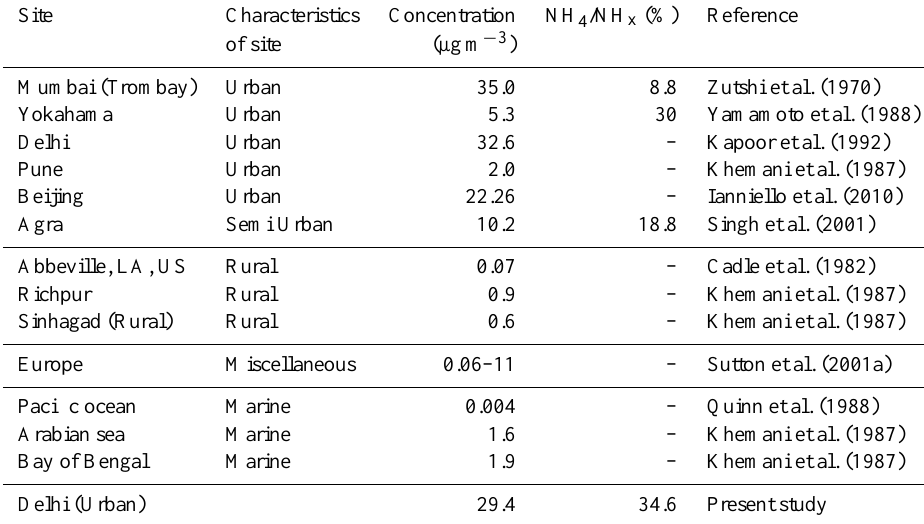
Fig. 4. Flow chart showing reason for higher NH 3 in Indian region. Table 1. Comparison of concentrations of gaseous ammonia with other